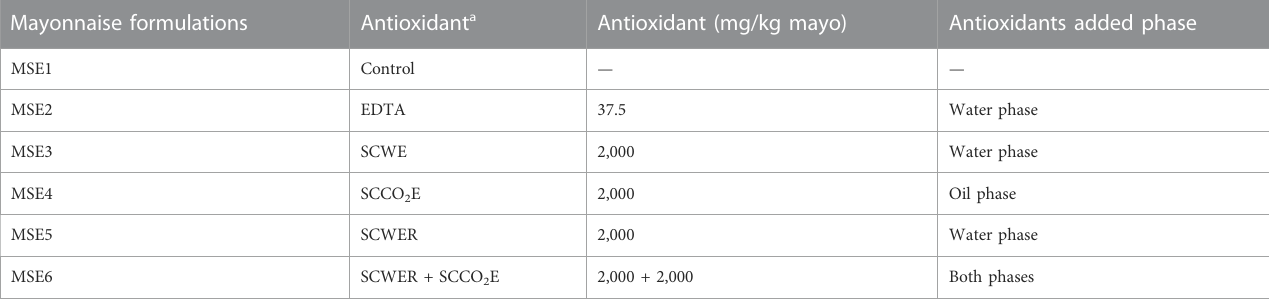
TABLE 1 The different mayonnaise, the type and amount of antioxidants added, and the phases in which the antioxidants were